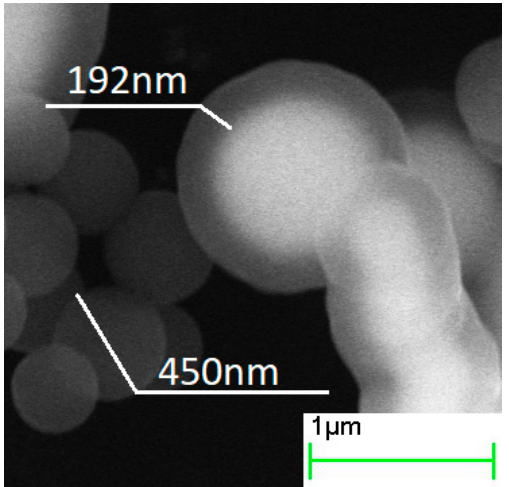
Figure 7. SEM images of core–shell particles obtained in the process with [TEOS]/[NH 3 ·H 2 O] = 1.5 ammonia concentration.